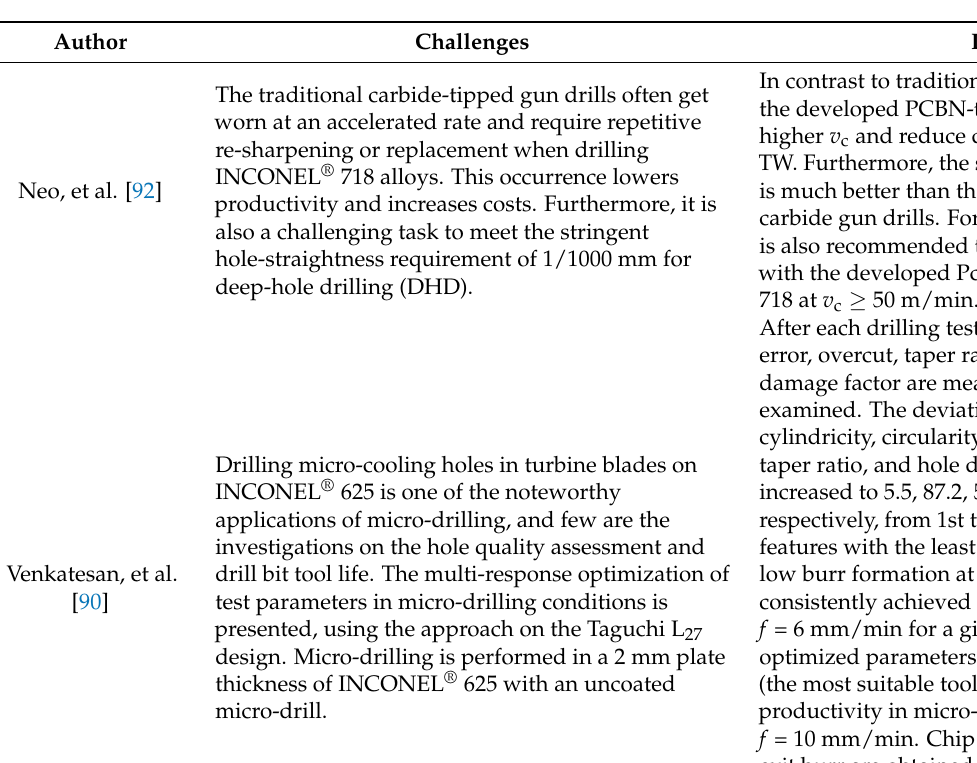
Table 8. Critical challenges and developments in the drilling process of INCONEL ®